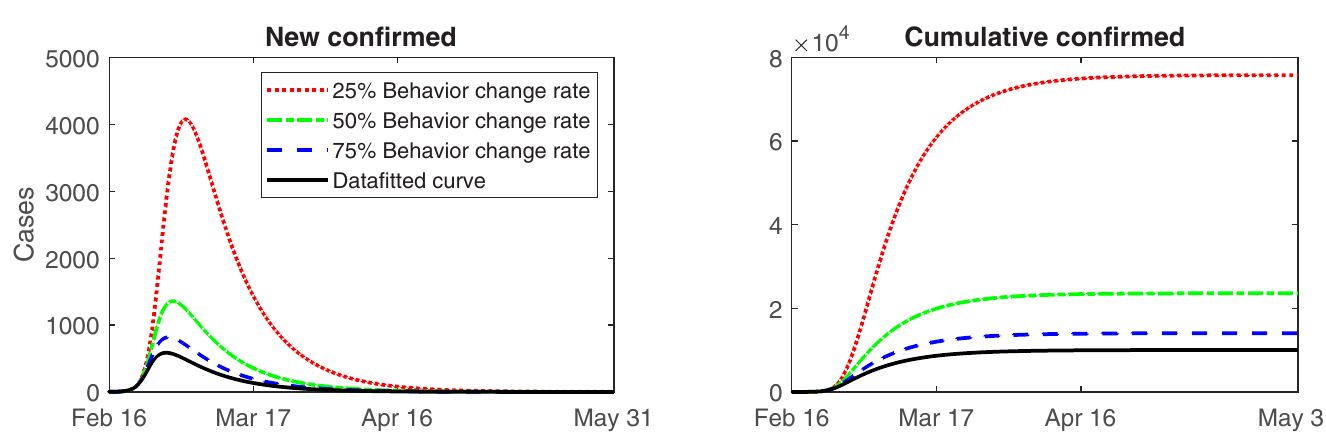
Fig 5. Expected number of cases as the public behavior change measures are reduced. Daily (left) and cumulative (right) number of confirmed cases.